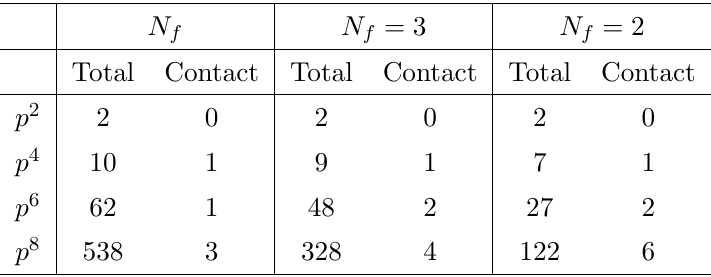
Table 5 . Number of monomials in the minimal basis for the case with no vector or axial-vector external (cid:12)elds included. Also listed is how many of them are contact